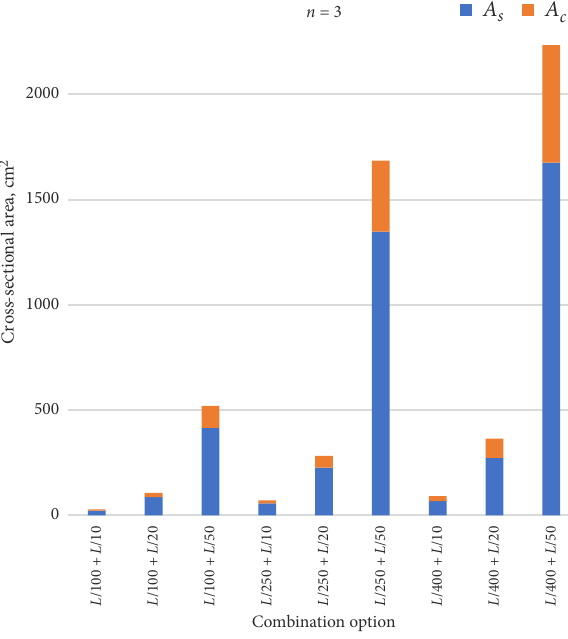
Figure 3. Dependence of the cross-sectional areas of the string and the lower cable on the limit displacements and the initial sag of the lower rope when n = 3. Here: n – the ratio of the cross-sectional areas of the string and the lower cable